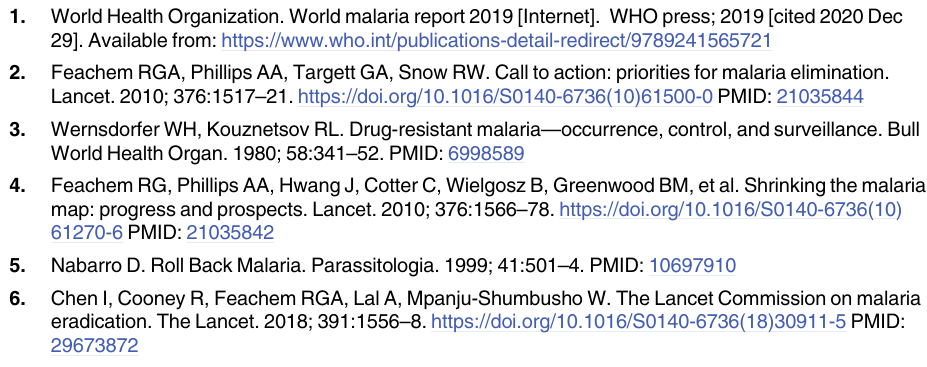
change in MARE for simulated malaria when individual entomological functions are decou- pled from climate. Fig F. Relative error of mean posterior estimate of true parameters, over 10 iterations. Fig G. Percent change in RMSE of simulations of malaria incidence (left pane) and mosquito density (right pane) under various k and Δ T values relative to default model condi- tions. Fig H. Attack rate difference between simulated incidence generated across study sites using observed weekly temperature data and weekly average temperatures. Fig I . Difference of model predicted attack rate as proportion of full-treatment (f ) deviate from final model con- T ditions. Fig J . Boxplots of average province-level attack rates of malaria incidence, predicted under continuous simulation. Fig K . The relationship between the malaria force of infection and model estimated weekly average EIR for sites found in the study provinces. Table A. Mean and 95% credible interval of posterior ensemble of model parameter estimates. Table B. Mean and 95% confidence interval estimates of k , the common rate of dispersion within the OEV for model-EAKF